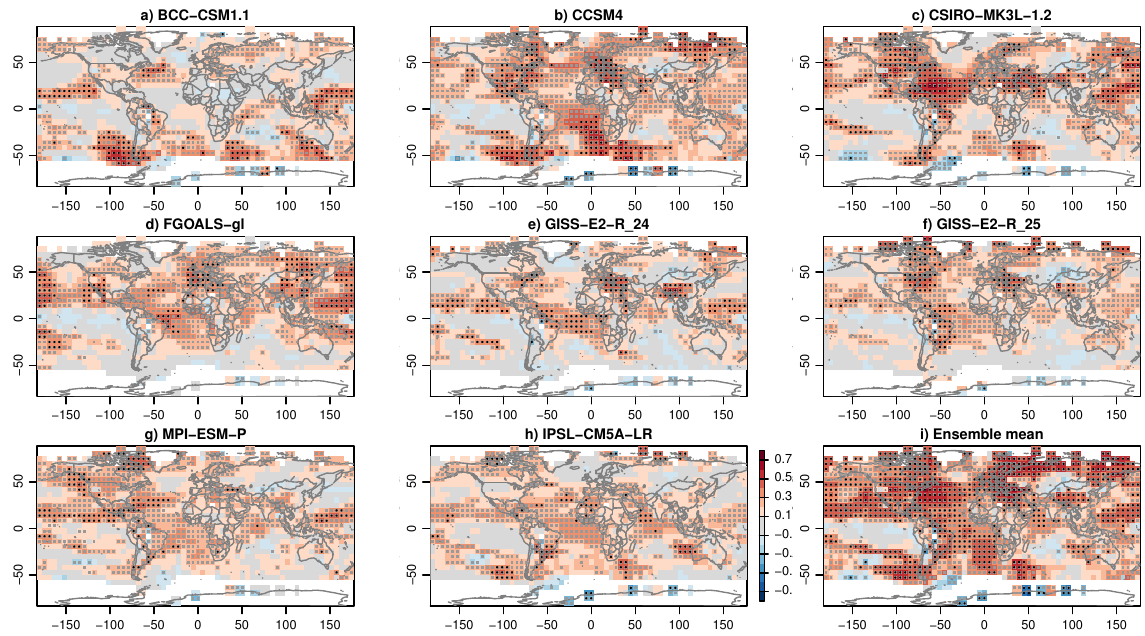
Fig. 3. Mapped grid-point correlation coefficients between surface air temperature series from the considered simulations and from the reconstruction. See panel titles for individual simulations. Ensemble mean in (i) . Grey (black) dots mark two-sided 90% (99%)